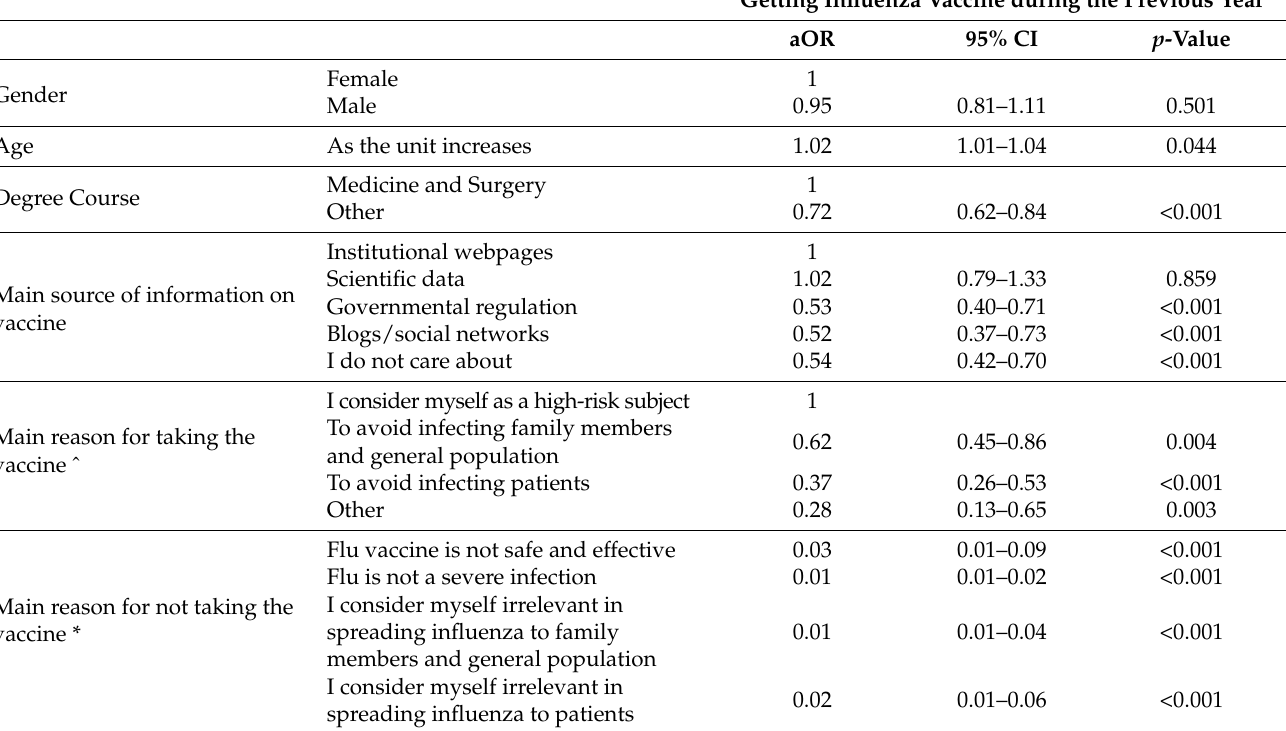
Table 2. Multivariable logistic regression for getting influenza vaccine during the last campaign. Adjusted Odds Ratios (aOR) are presented. Each independent variable is adjusted for gender and age. Based on 3131